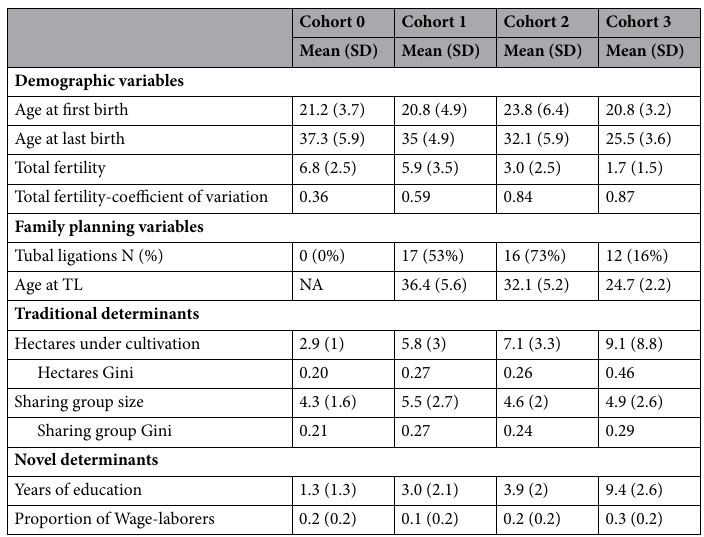
Table 2. Descriptive statistics of model variables by cohort. Total fertility is defined as the total number of live births by a woman in the year 2017. For Cohort 0, 1, and 2, total fertility is equivalent to Completed Fertility. Descriptive accounts of variable creation are presented in Supplementary